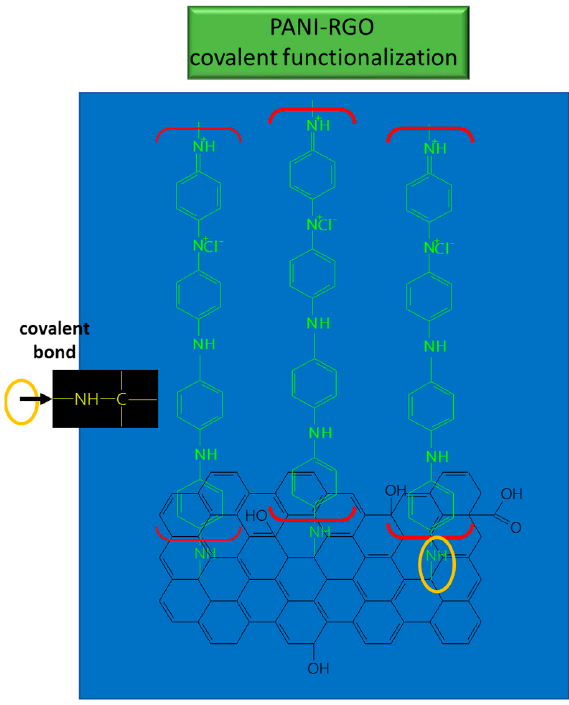
Figure 9. Interaction between RGO and PANI in the composite used for UA detection.